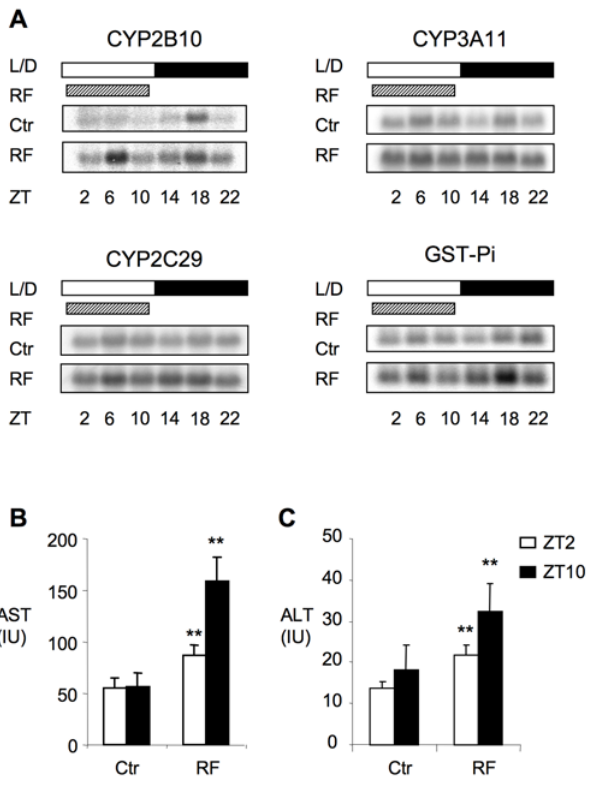
Figure 4. Restricted feeding induction of genes involved in liver stress response and associated liver injury. A. Gene expression and B. serum AST and ALT level (n=8–10) after 1 week of RF. Values are expressed as mean 6 SE. * P , 0.05 and **P , 0.01 compared to corresponding time point. doi:10.1371/journal.pone.0006843.g004 Figure 3. Expression of genes of core circadian rhythm